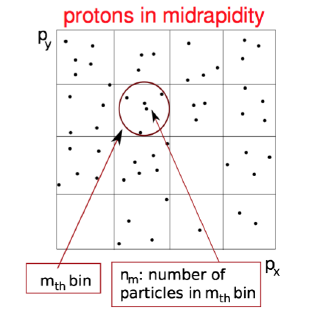
Figure 4. Definition of cells in the proton intermittency analysis in Be + Be at 150 A GeV / c